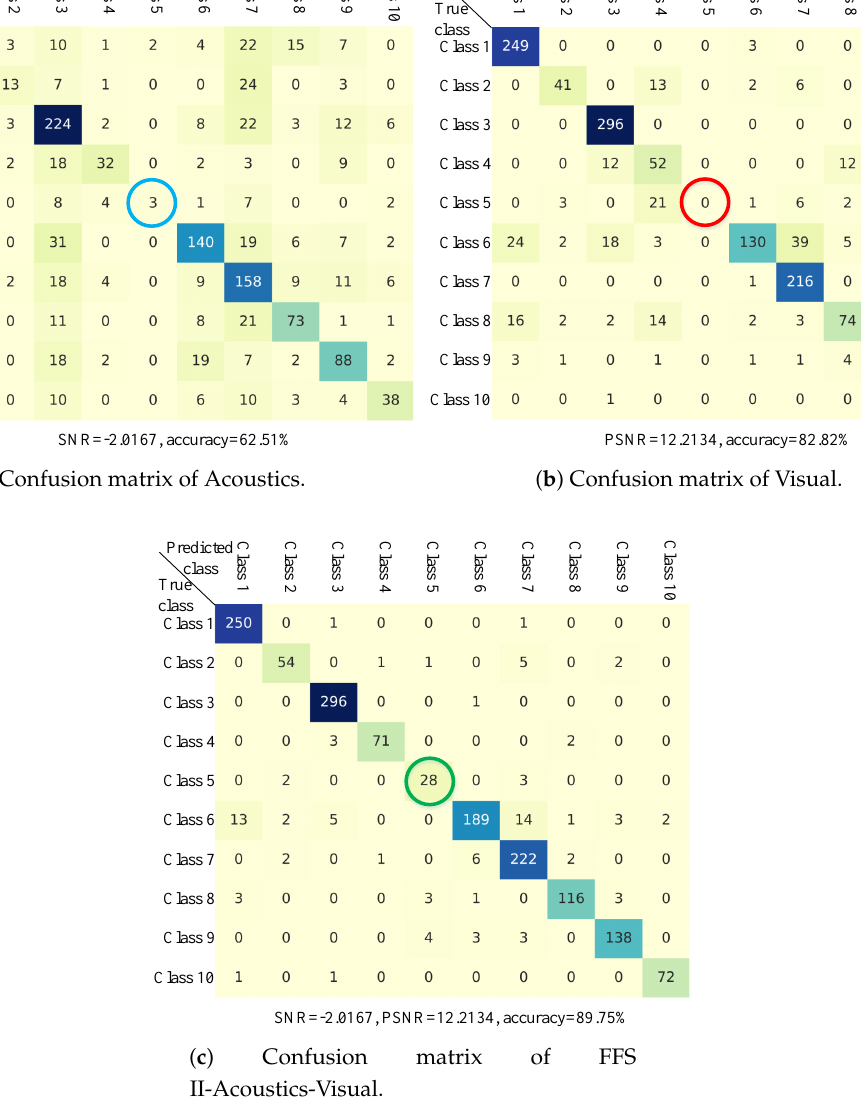
Figure 10. Confusion matrices of single-modality and